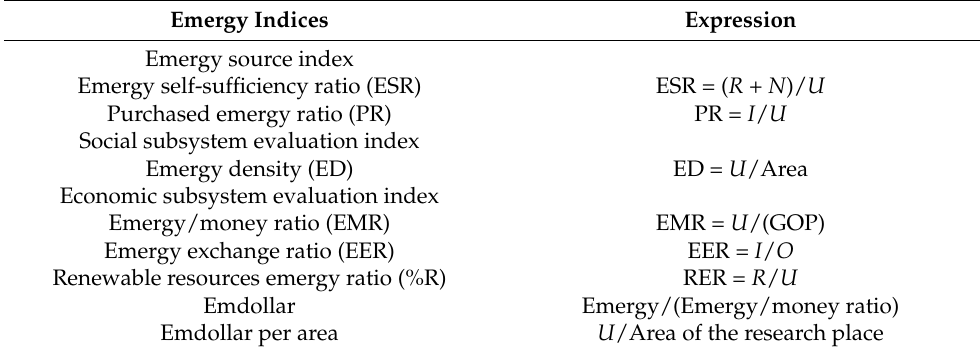
Table 2. Emergy indices of sea area eco-economic